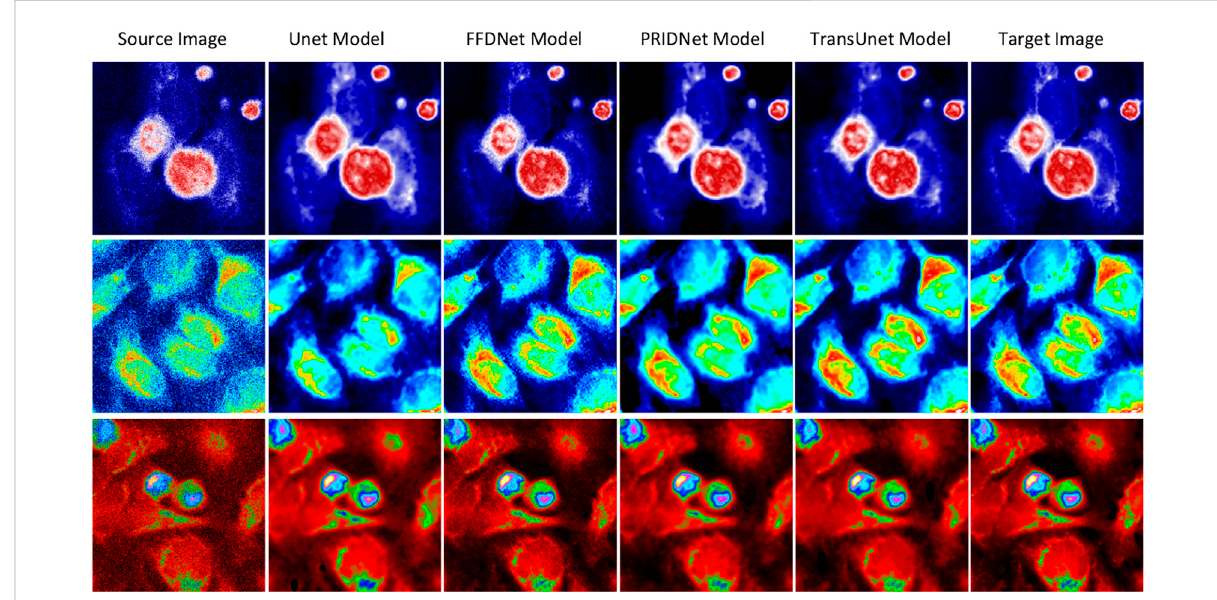
FIGURE 7 Results of deep-learning-based image denoising. Different stains and cell cultures. The fi rst column shows the source optical images of Hela cells; the second column shows the ground truth optical images; and the following two columns display the denoising results by UNet and MultiFusion models,